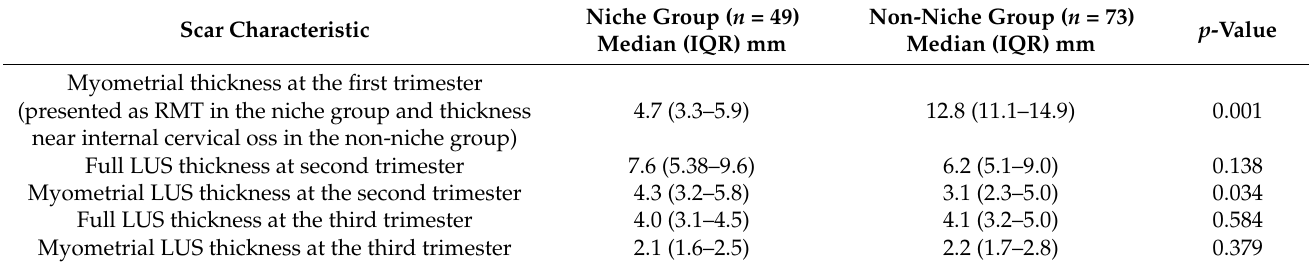
Figure 4. Median scar myometrial thickness (mm) according to trimester of pregnancy. Data are presented as median (IQR). Table 3. Uterine CS scar thickness during pregnancy trimesters in the niche and non-niche participant